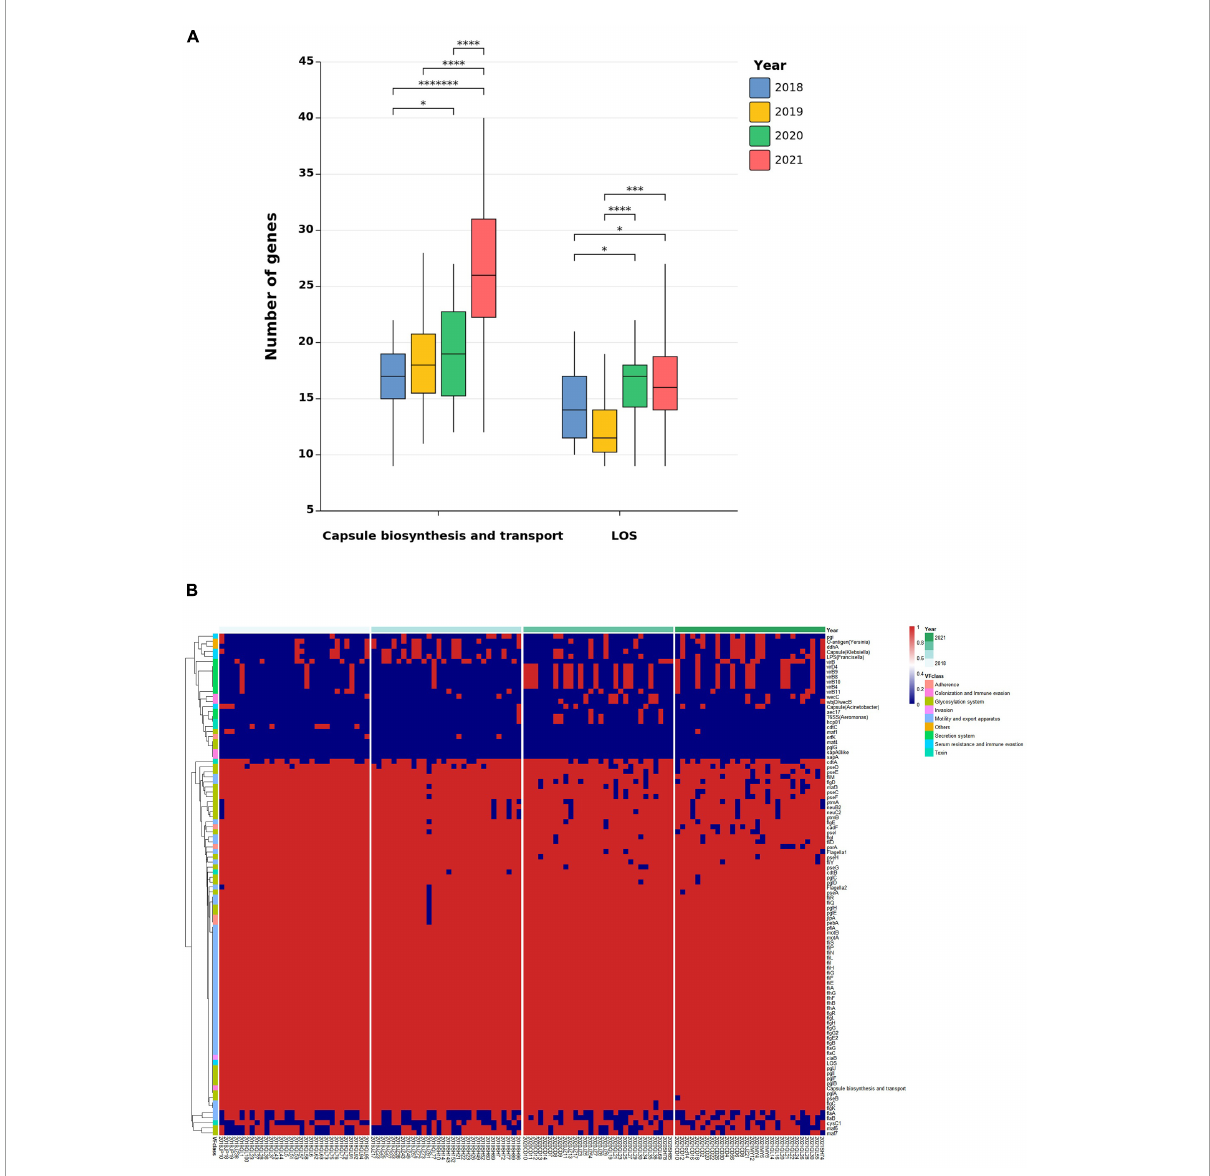
FIGURE4 The distribution of virulence genes in Campylobacter isolates. (A) Predicted numbers of capsule- and LOS-related virulence genes in Campylobacter isolates (Blue: 2018, Yellow: 2019, Green: 2020, and Pink: 2021; the median number of genes is denoted as the horizontal line inside the boxplot. ∗ p < 0.05; ∗∗∗ p < 0.0001; ∗∗∗∗ p < 0.00001, ∗∗∗∗∗∗∗ p < 0.0000001). (B) Heatmap of Campylobacter virulence genes isolated over 4 years (hierarchical clustering of Y -axis virulence genes, blue: absence, and red: